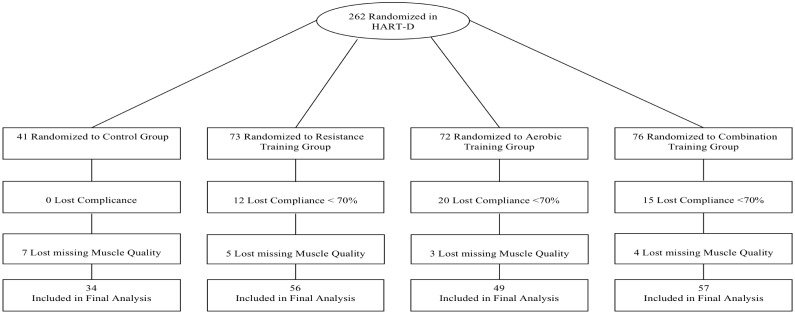
Consort diagram.